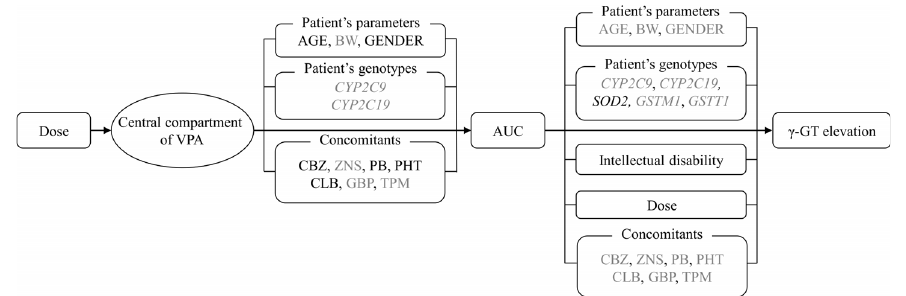
Figure 2. The relationships evaluated in the framework for the c -GT elevation during VPA therapy. The solid lines indicate the relationships included in the final population PK and PK-PD models. Black letters indicate relationships included in the final models, and grey letters indicate relationships investigated, but not included, in the final models. PK=pharmacokinetic; PD=pharmacodynamics; VPA=valproic acid c -GT: c -